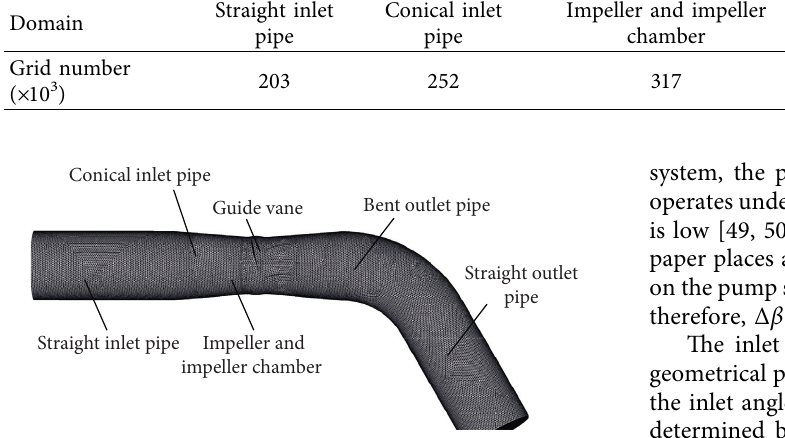
Figure 2: Grid generation of the computational domain.